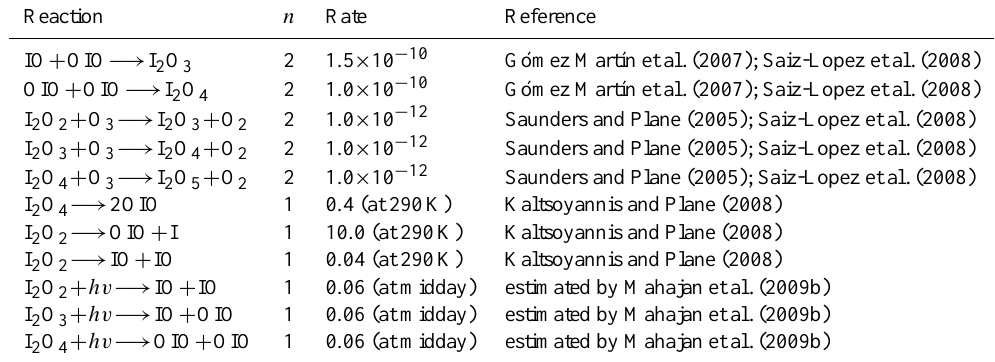
Table 1. Additional I x O y chemistry. n is the order of the reaction. Reaction rates are given in (cm − 3 ) 1 − n s − 1